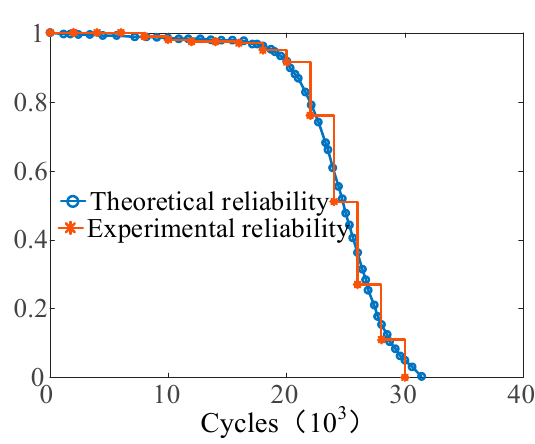
Figure 12. Practical and theoretical comparison.